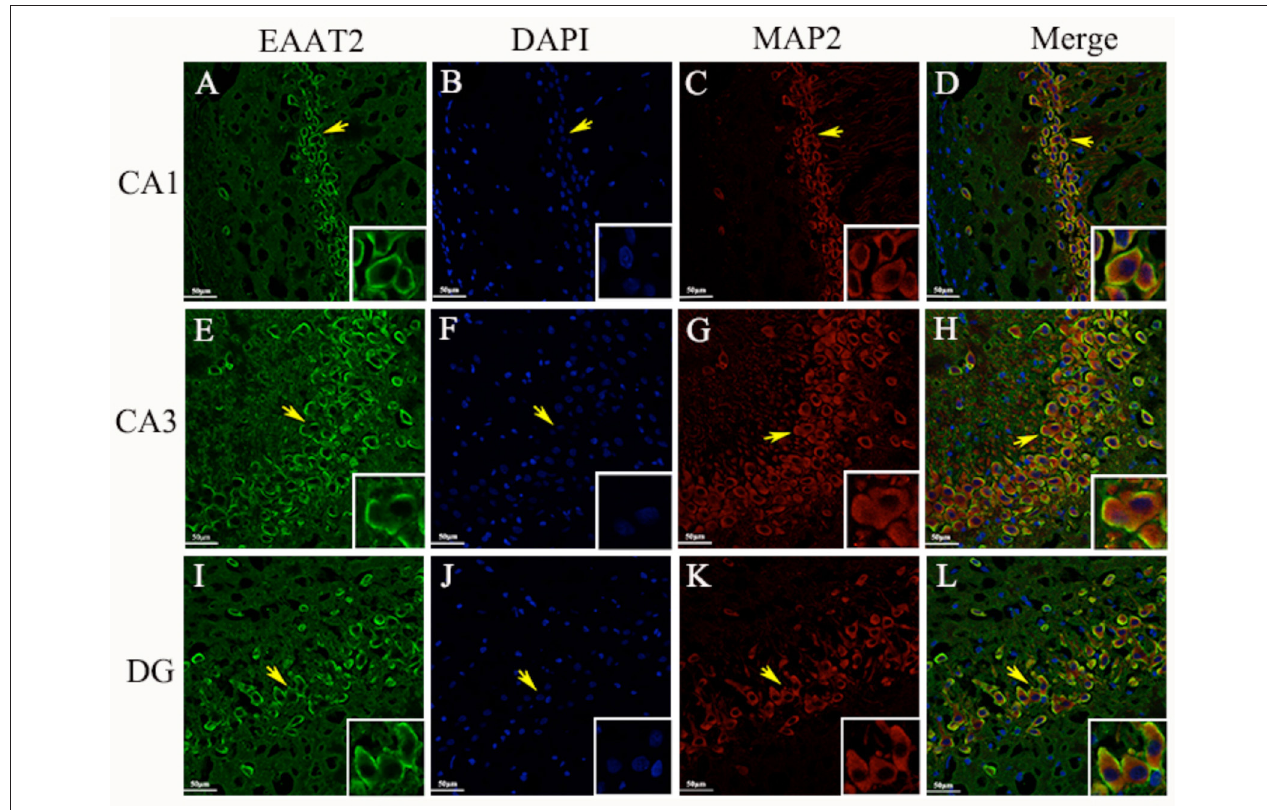
FIGURE 7 | Neuronal cells (A–L) . EAAT2 expression in the CA1, CA3, and DG hippocampal areas in rats measured 3 d after seizure onset by double-labeling immunofluorescence (yellow arrows indicate neurons; white arrows indicate astroglia-like cells) (scale: 20 µ